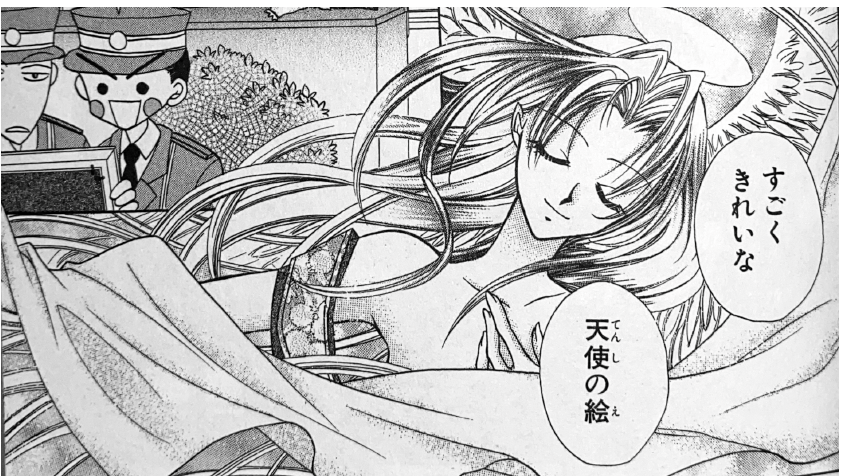
Figure 5 Image of an angel that appeared in a frame after Jeanne concealed a demon (Tanemura